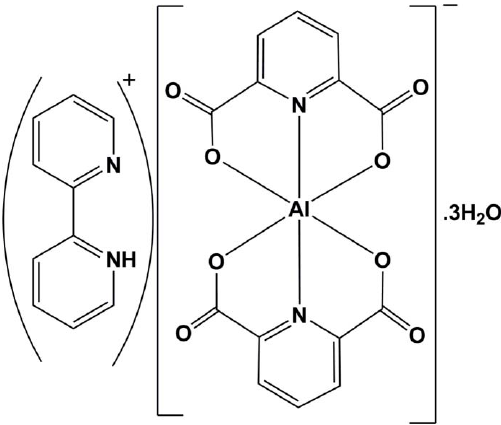
Experimental Crystal data